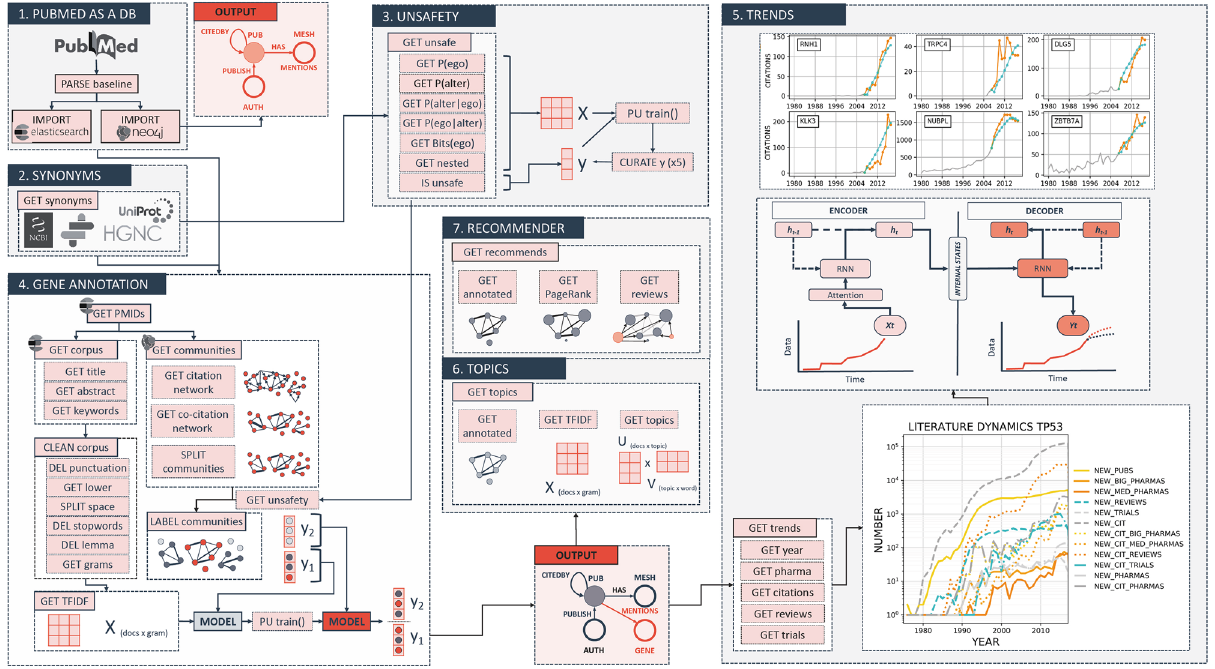
Figure 1. Workflow. Chart summarising the process from the downloading of the data to the detection and analysis of trends in the literature. ( A ) Creation of a graph database with the information contained in PubMed baseline 2020. ( B ) Acquisition of a comprehensive collection of human coding gene names and synonyms. ( C ) Automatic determination of potential ambiguous (unsafe) gene names. ( D ) Annotation of the graph database with unambiguous gene symbols by combining co-citation network topology and binary classifiers. ( E ) Prediction of per-gene publication trends using RNN. When a gene has significantly more publications or citations than expected by the model it is considered to be trendy. ( F ) Automatic topic detection of collections of publications. We used this algorithm to quantify the evolution of topics in trendy gene publications over time. ( G ) A review recommender system that uses information from the citation network and topic detection to recommend the most efficient set of reviews to explore the